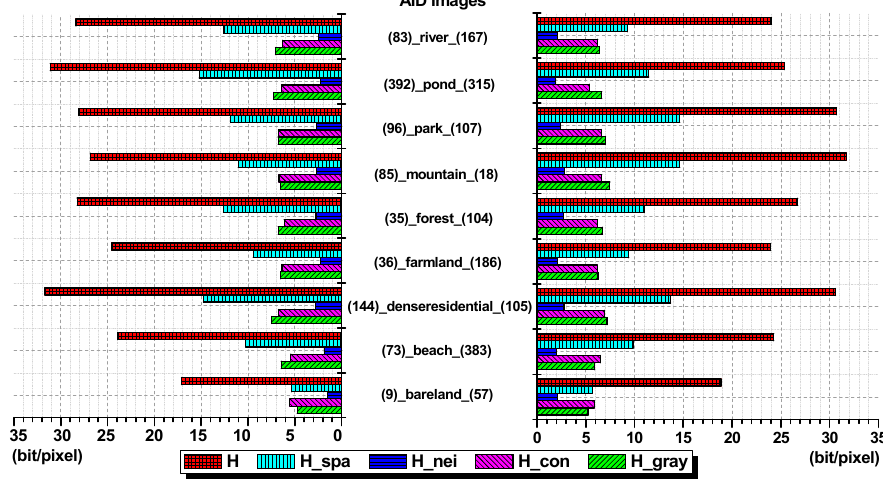
Figure 6. Random samples from the AID scene dataset. AID Images